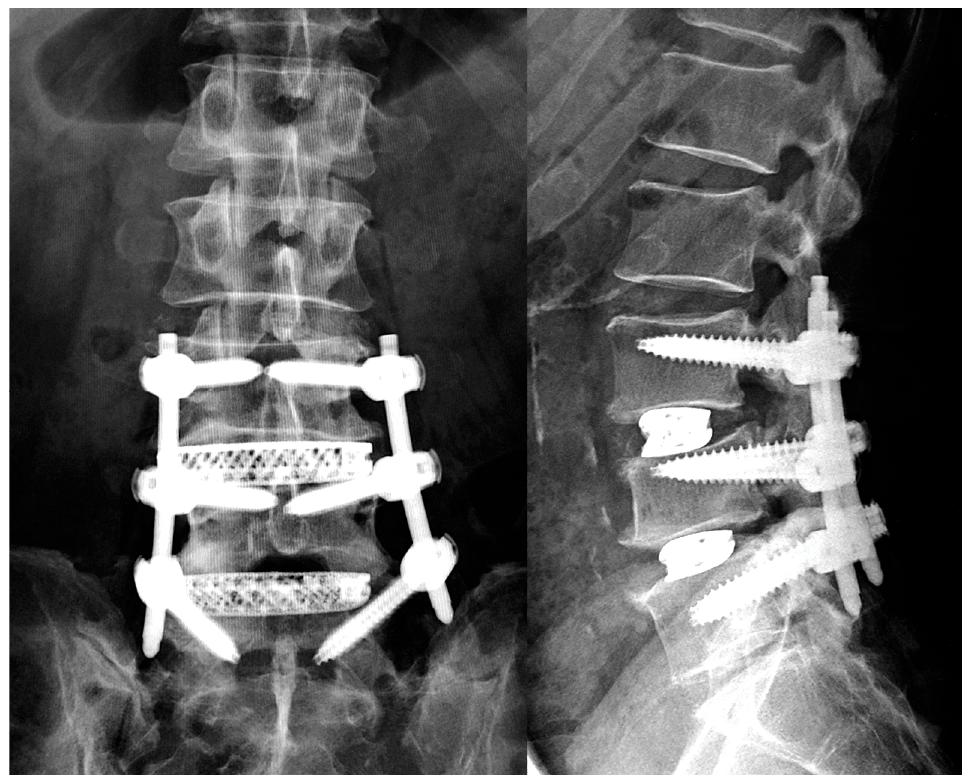
Figure 1. Lumbar degenerative spondylolisthesis treated by 3DTi cage and PPS. Unintentional intraoperative endplate injuries in XLIF have been identified in 10.4%